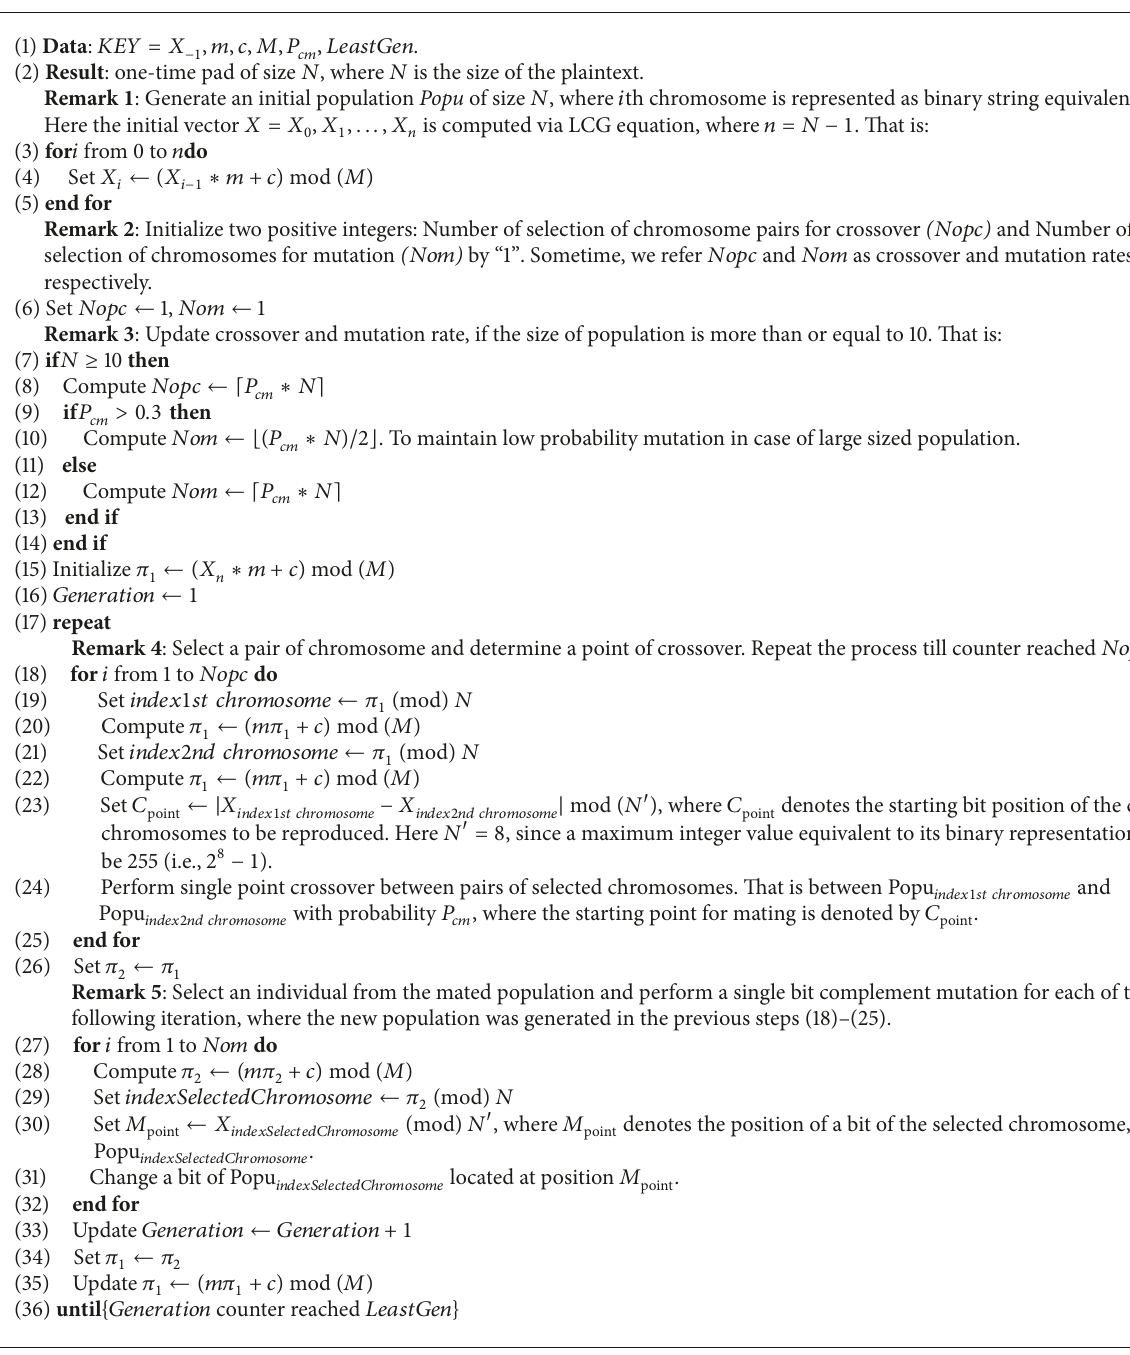
Algorithm 1: Pseudocode of the IGRKG